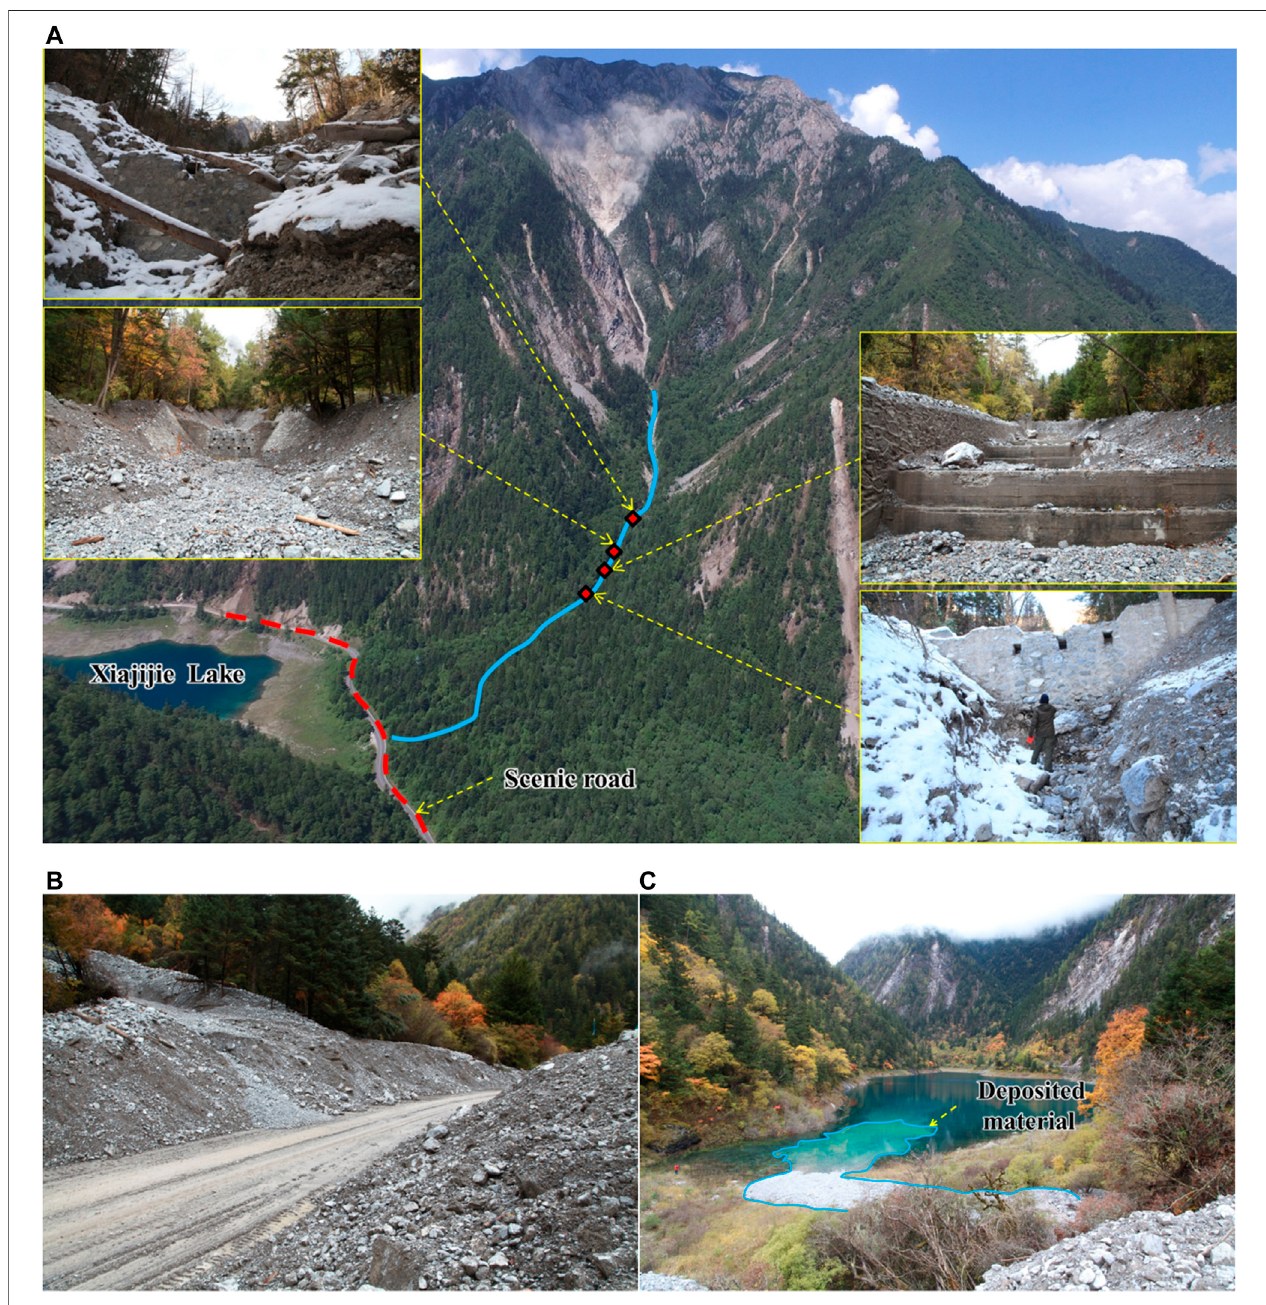
FIGURE3| ViewofXiajijieLakeGully. (A) ControlengineeringlayoutofXiajijieLakeGully(beforethedebris fl oweventonJune21,2019).Thebluelineinthe fi gurerepresents the main channel; (B) Debris fl ow material deposited on the scenic road on September 25, 2017; (C) Debris fl ow material entering Xiajijie Lake on September 25, 2017.